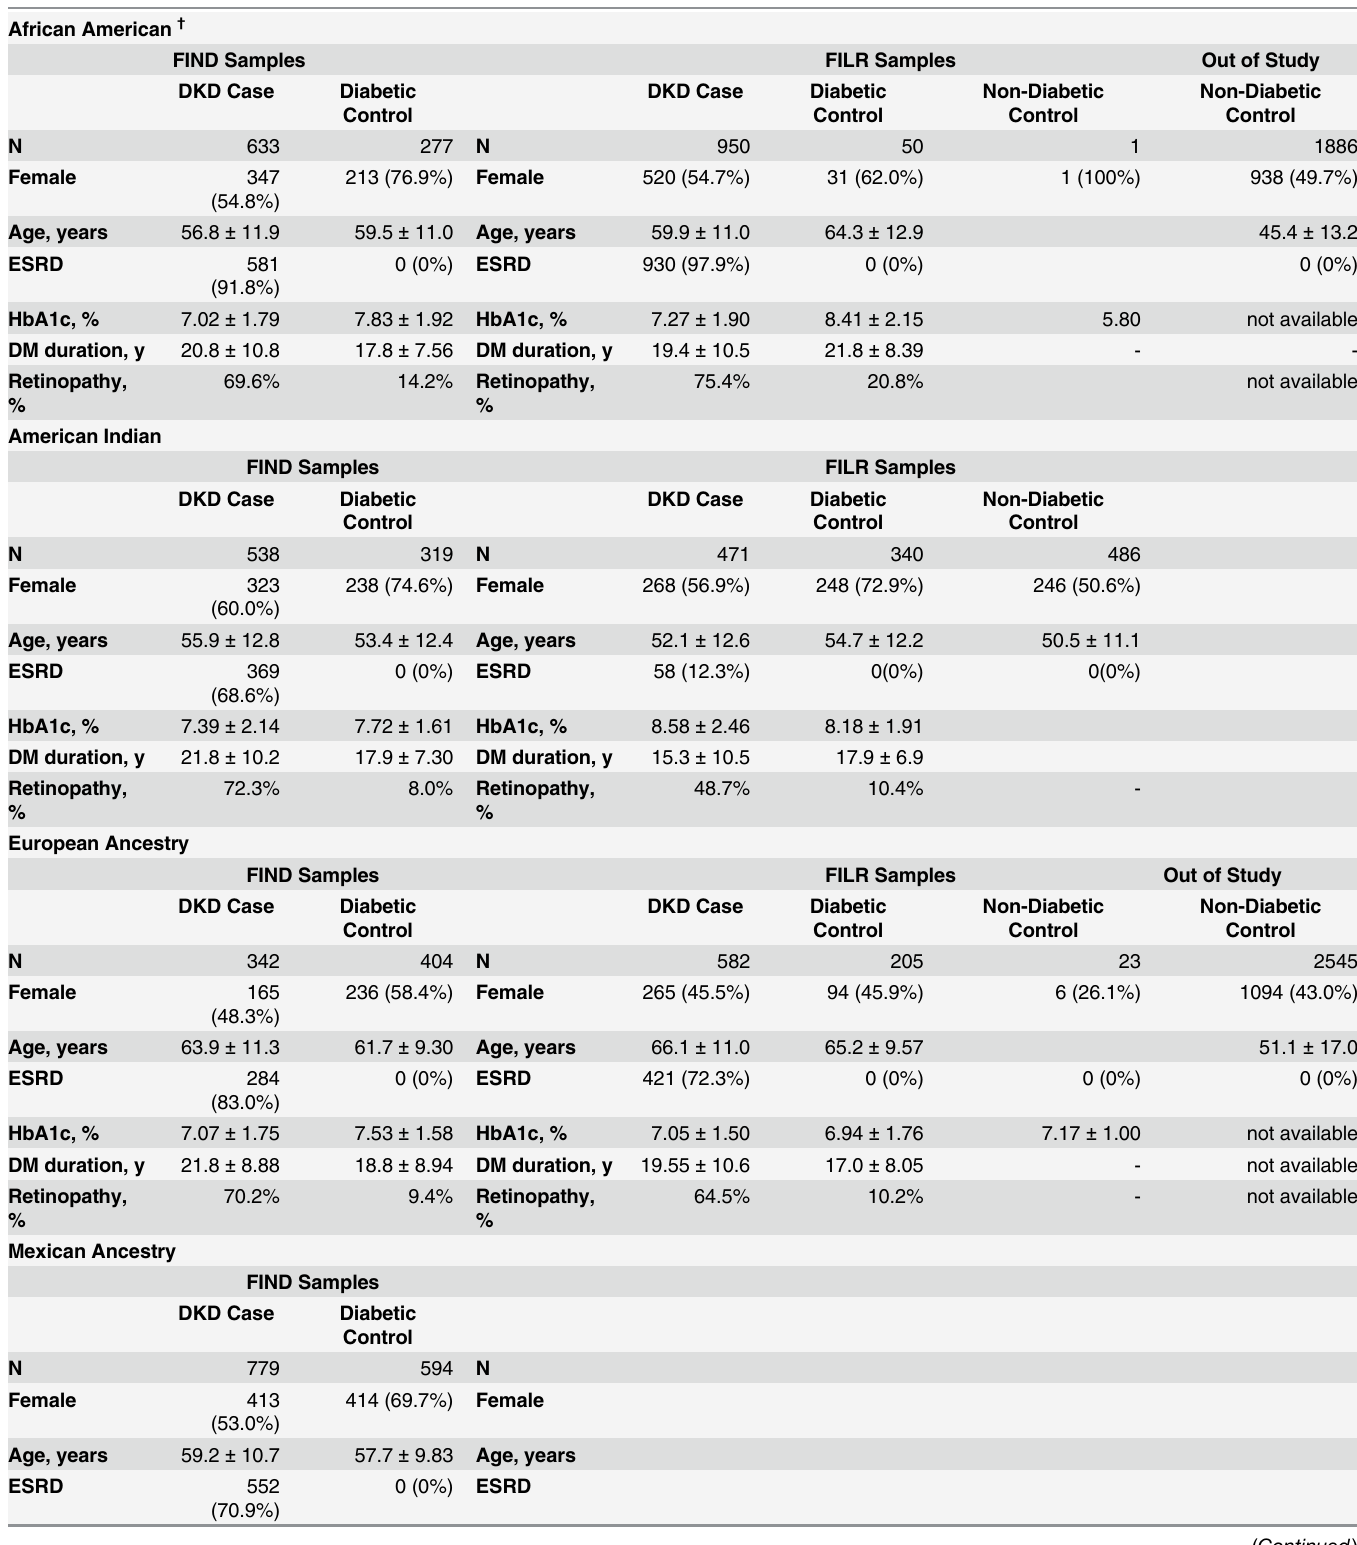
Table 1. Demographic characteristics of study